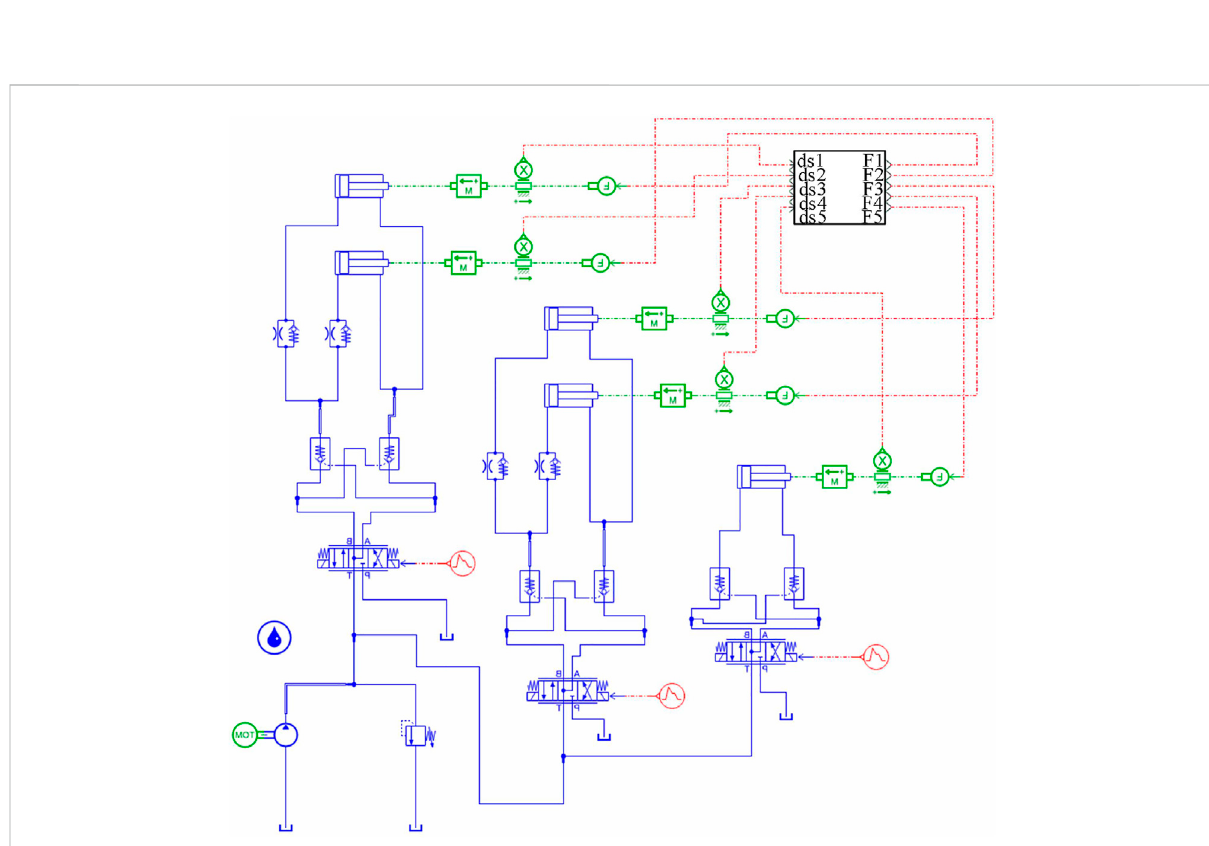
FIGURE 4 AMESim